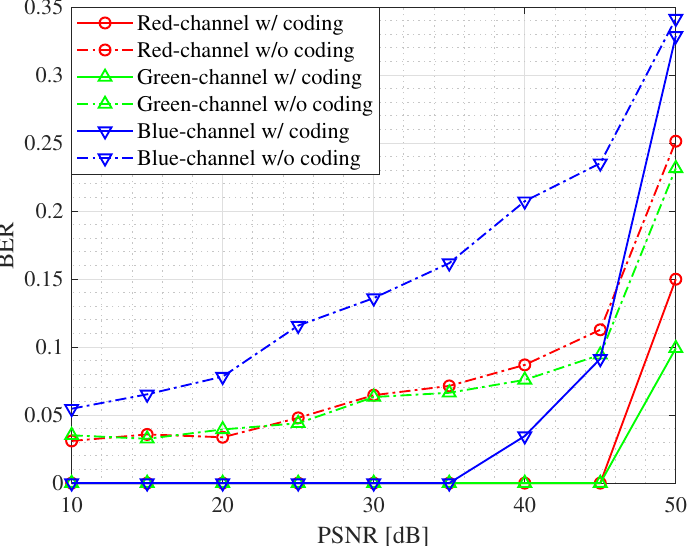
Figure 3. Performance comparison of DFC with and without channel coding for 256 × 256 pixel Lena image. The experiment was performed by averaging a total of 10 sets of Lena images in which different random data were